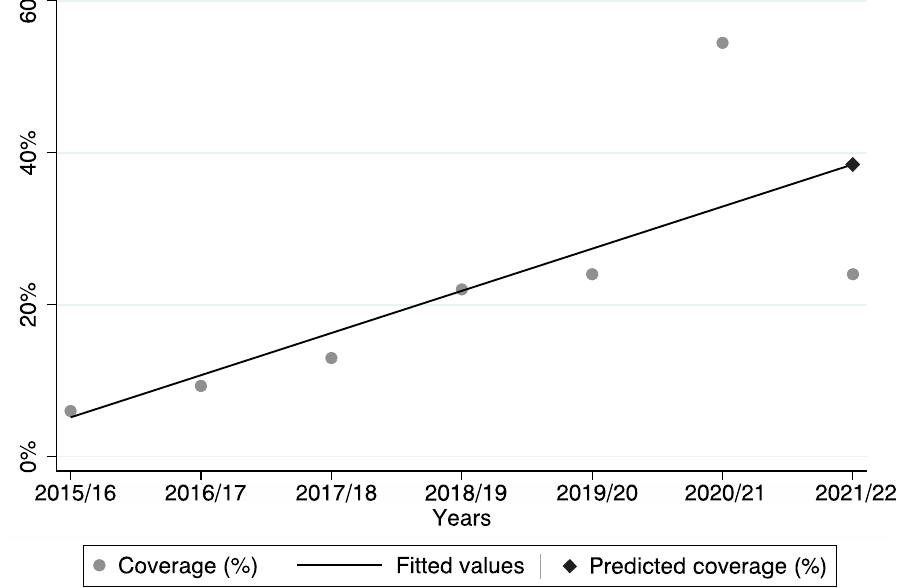
Figure 1. Predicted and observed vaccination coverage across the six vaccination campaigns.